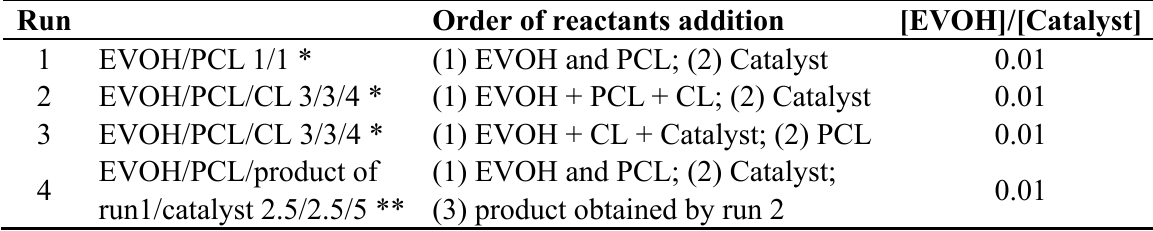
Table 1. Formulation used for alcoholysis reaction in a batch